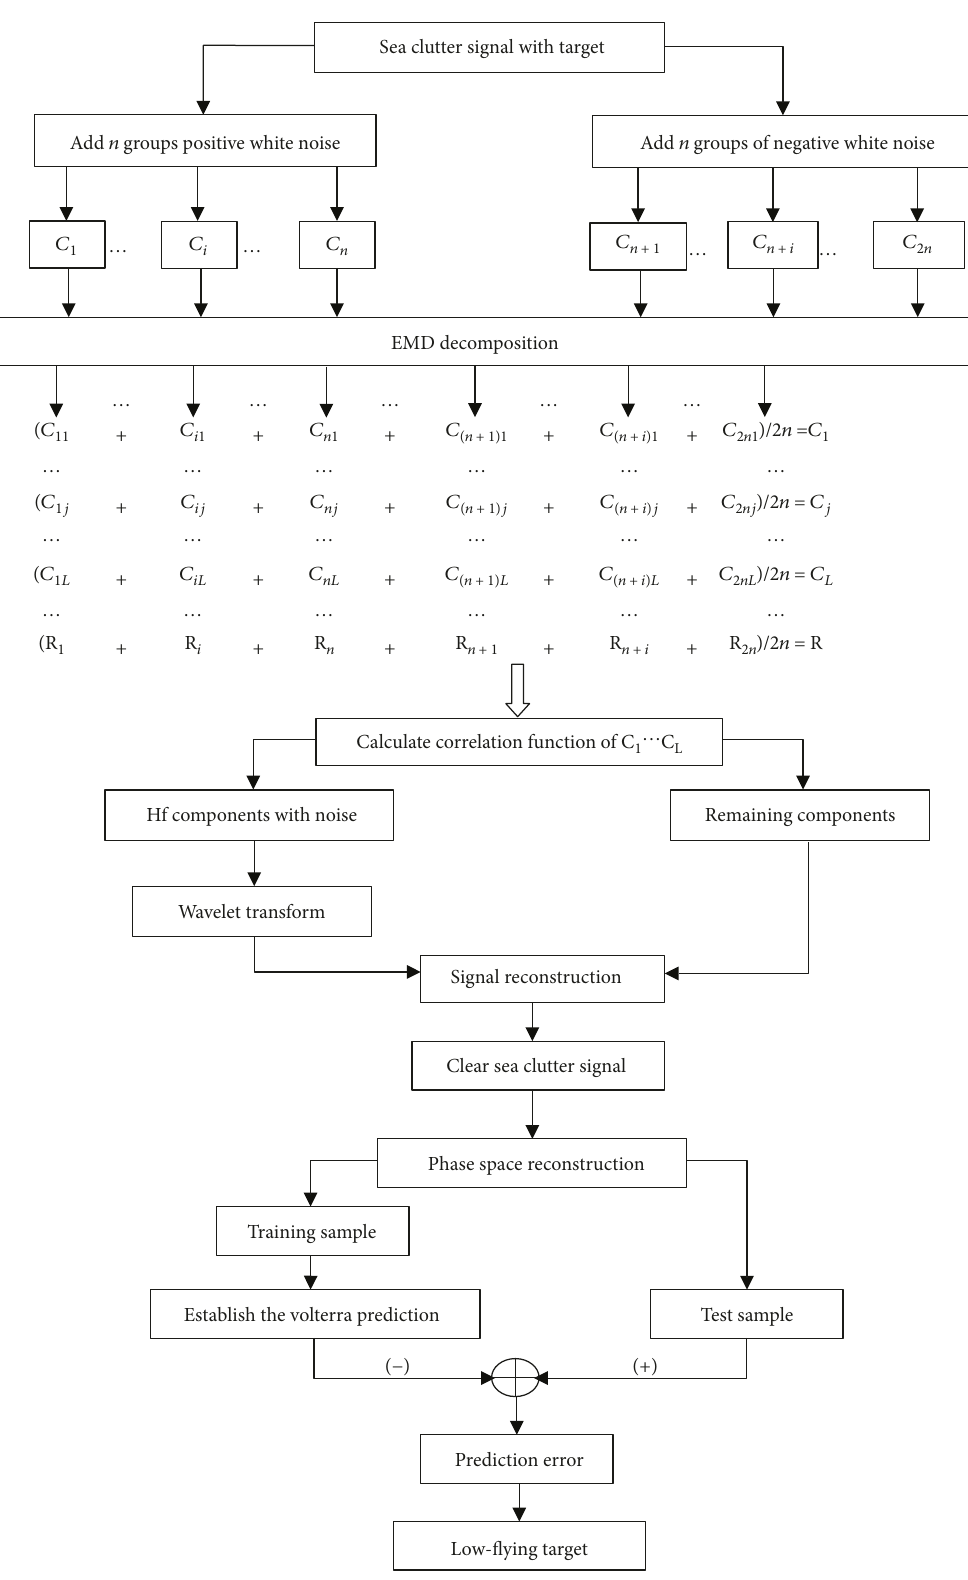
Figure 1: Detection process of low- fl ying target under sea clutter